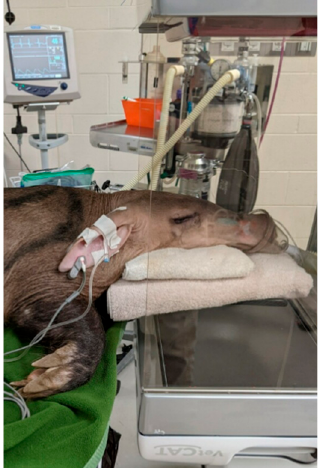
Figure 1. Photograph of aardvark under general anesthesia maintained on a face mask with the anterior portion of the head placed in the gantry of the cone-beam computed tomography (CBCT) unit. This image highlights the scanning range of the unit.